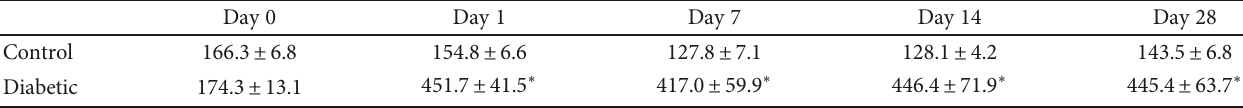
Table 1: Blood glucose levels (mg/dl) of diabetic and control rats.